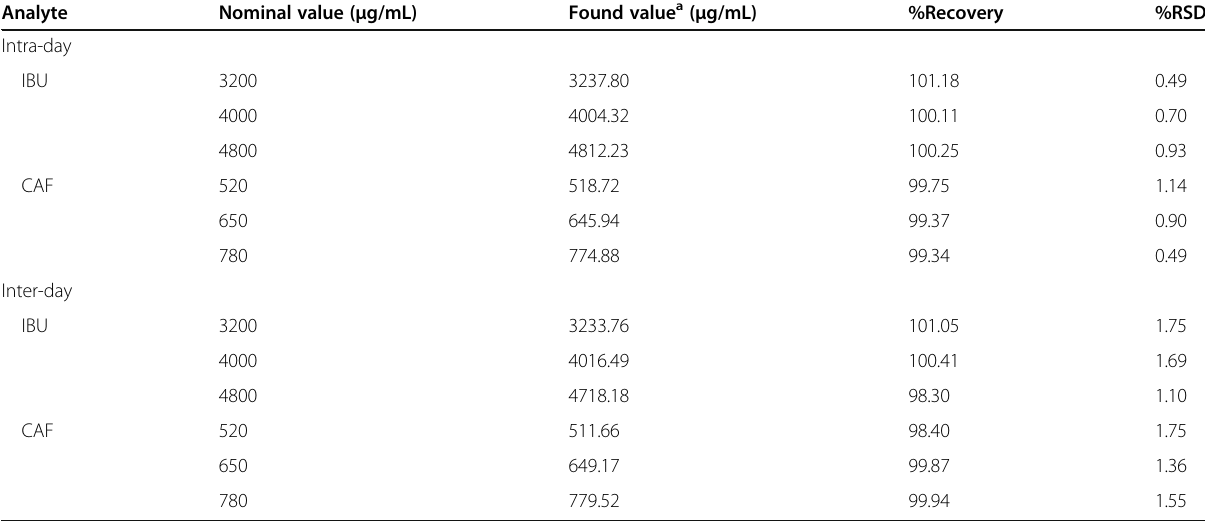
Table 3 Accuracy and precision for the determination of IBU and CAF Analyte